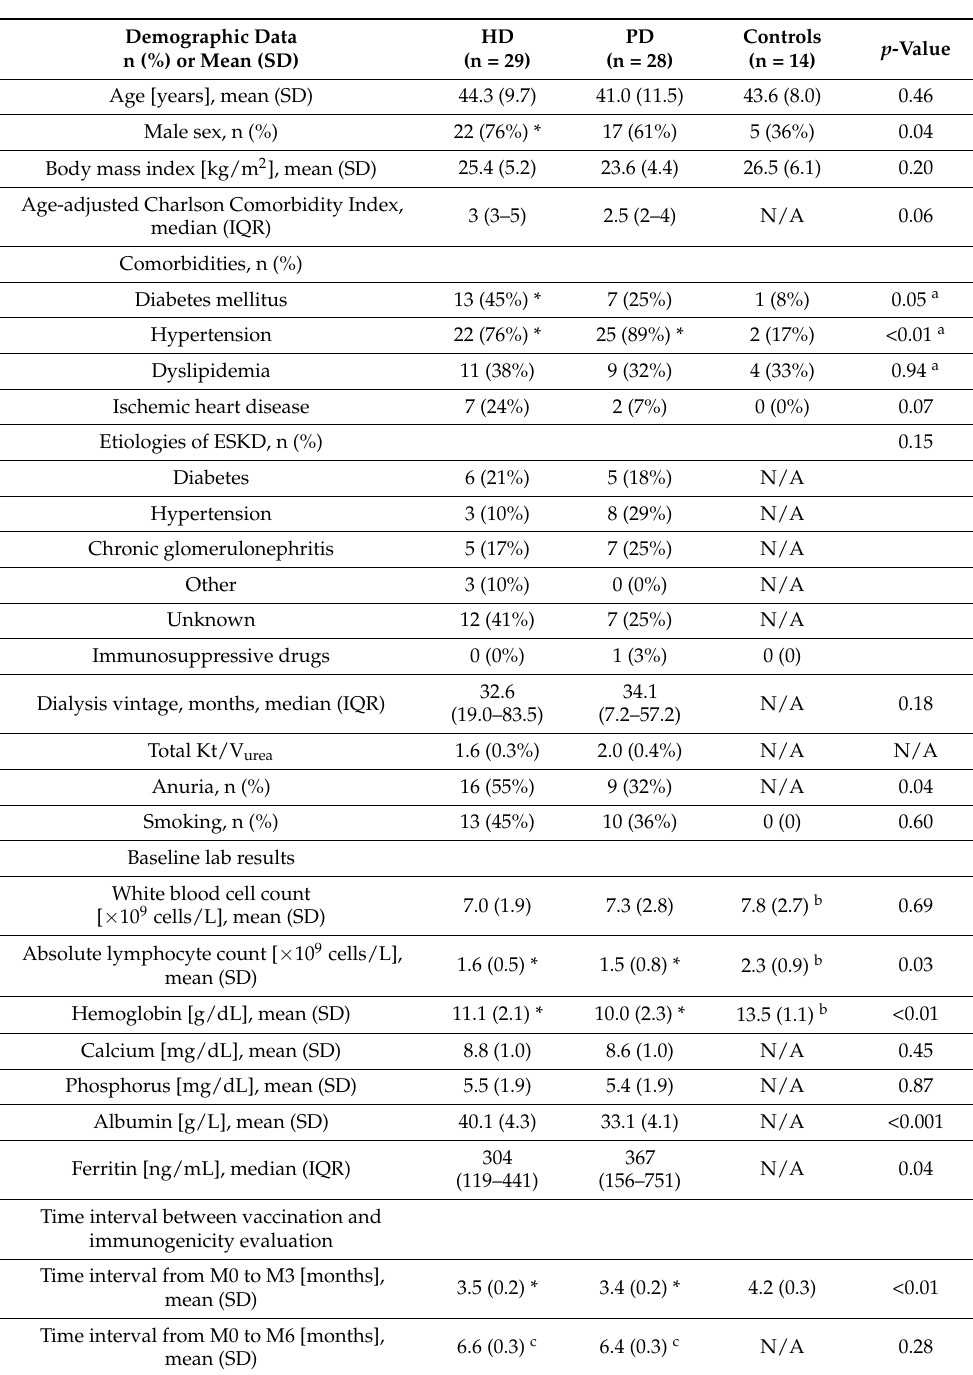
Table 1. Baseline demographic data and laboratory parameters of study